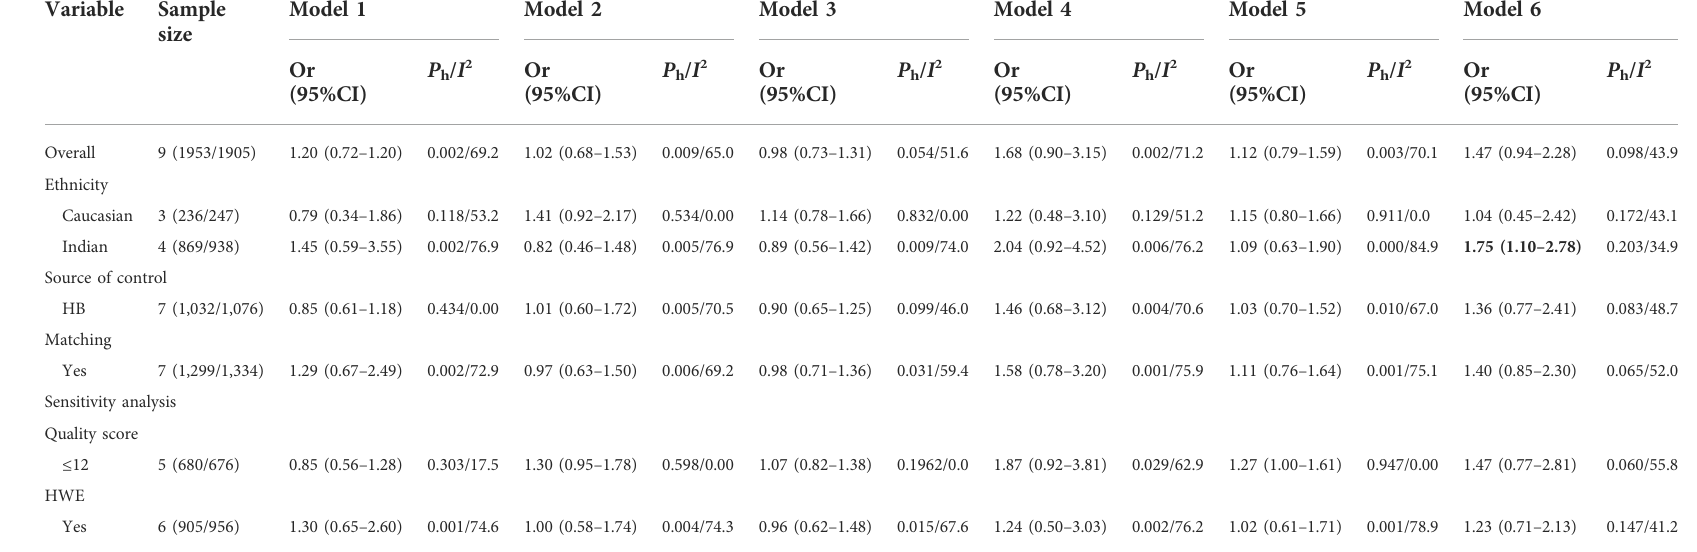
TABLE 6 Meta-analysis of the combined effects of GSTT1 present/null and GSTP1 IIe105Val on T2DM risk.